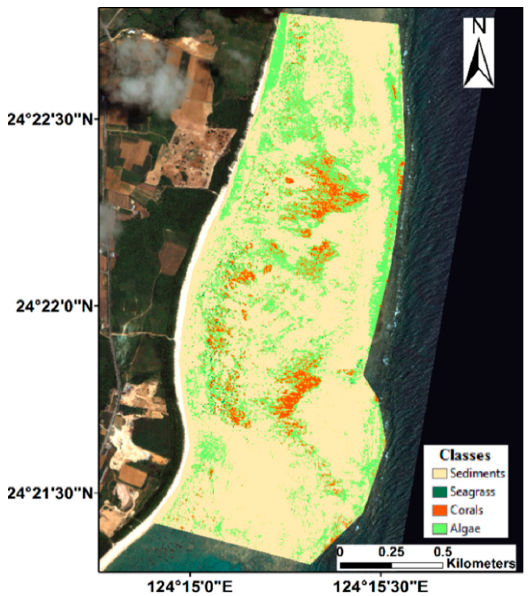
Figure 9. The benthic cover map of the Shiraho study area resulted from the Quickbird image using the WMV algorithm. Table 3. The OA and Kappa results of all methods for benthic habitats mapping for the Shiraho area. Methodology